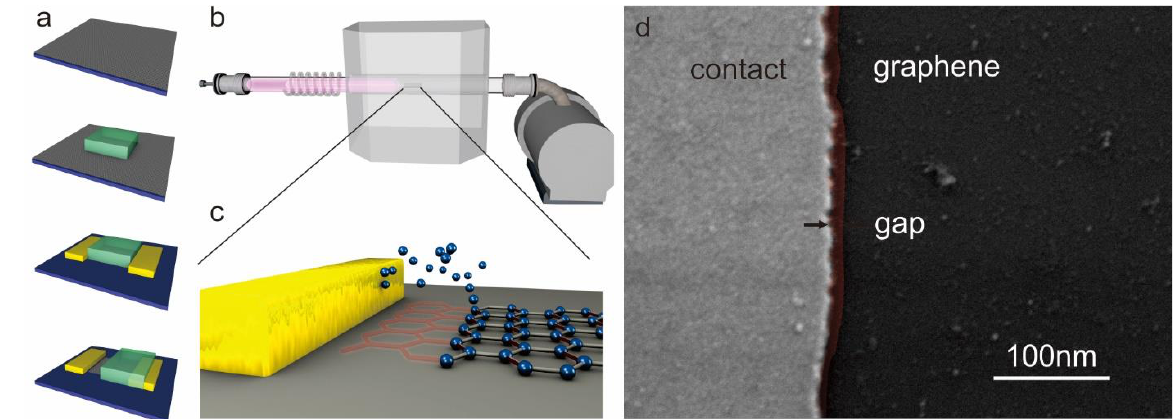
Figure 1. Method to producing lateral tunneling junctions. ( a ) Sequence of lithography steps to produce an edge-contacted 2D material prior to edge trimming (graphene transfer, photolithographic channel definition and isolation, edge contact deposition, lithographical protection of one contact); ( b ) depiction of the remote plasma chamber and close-up schematic of edge trimming between the metal contact and graphene edge; ( c ) schematic of the edge-trimming process that results in nanogaps between graphene and the edge contact; ( d ) scanning electron micrograph of produced structure with the indication of gap position.